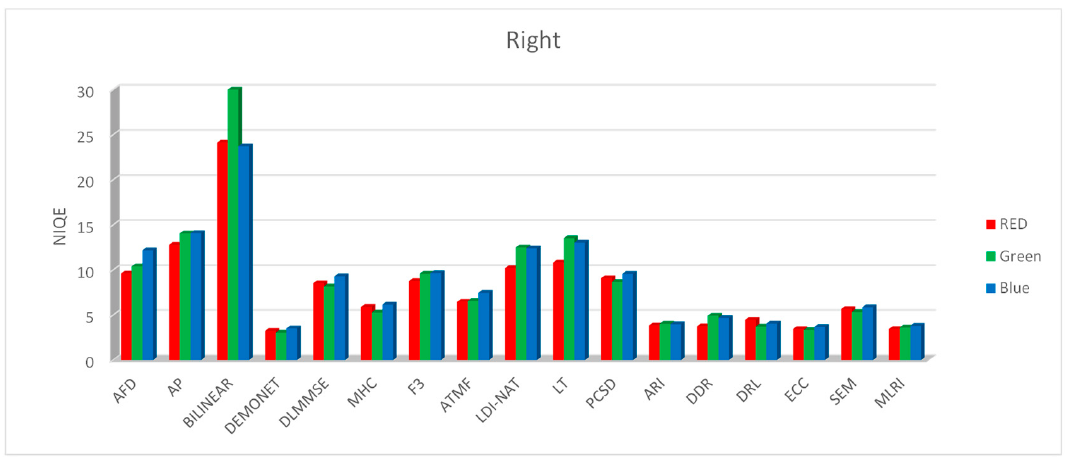
Figure 9. Averaged NIQE scores of different bands using all methods for right images.